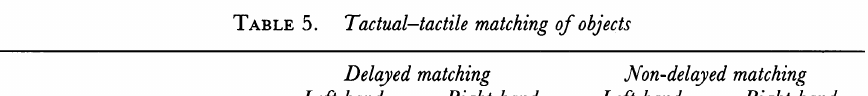
TABLE 5. Tactual-tactile matching